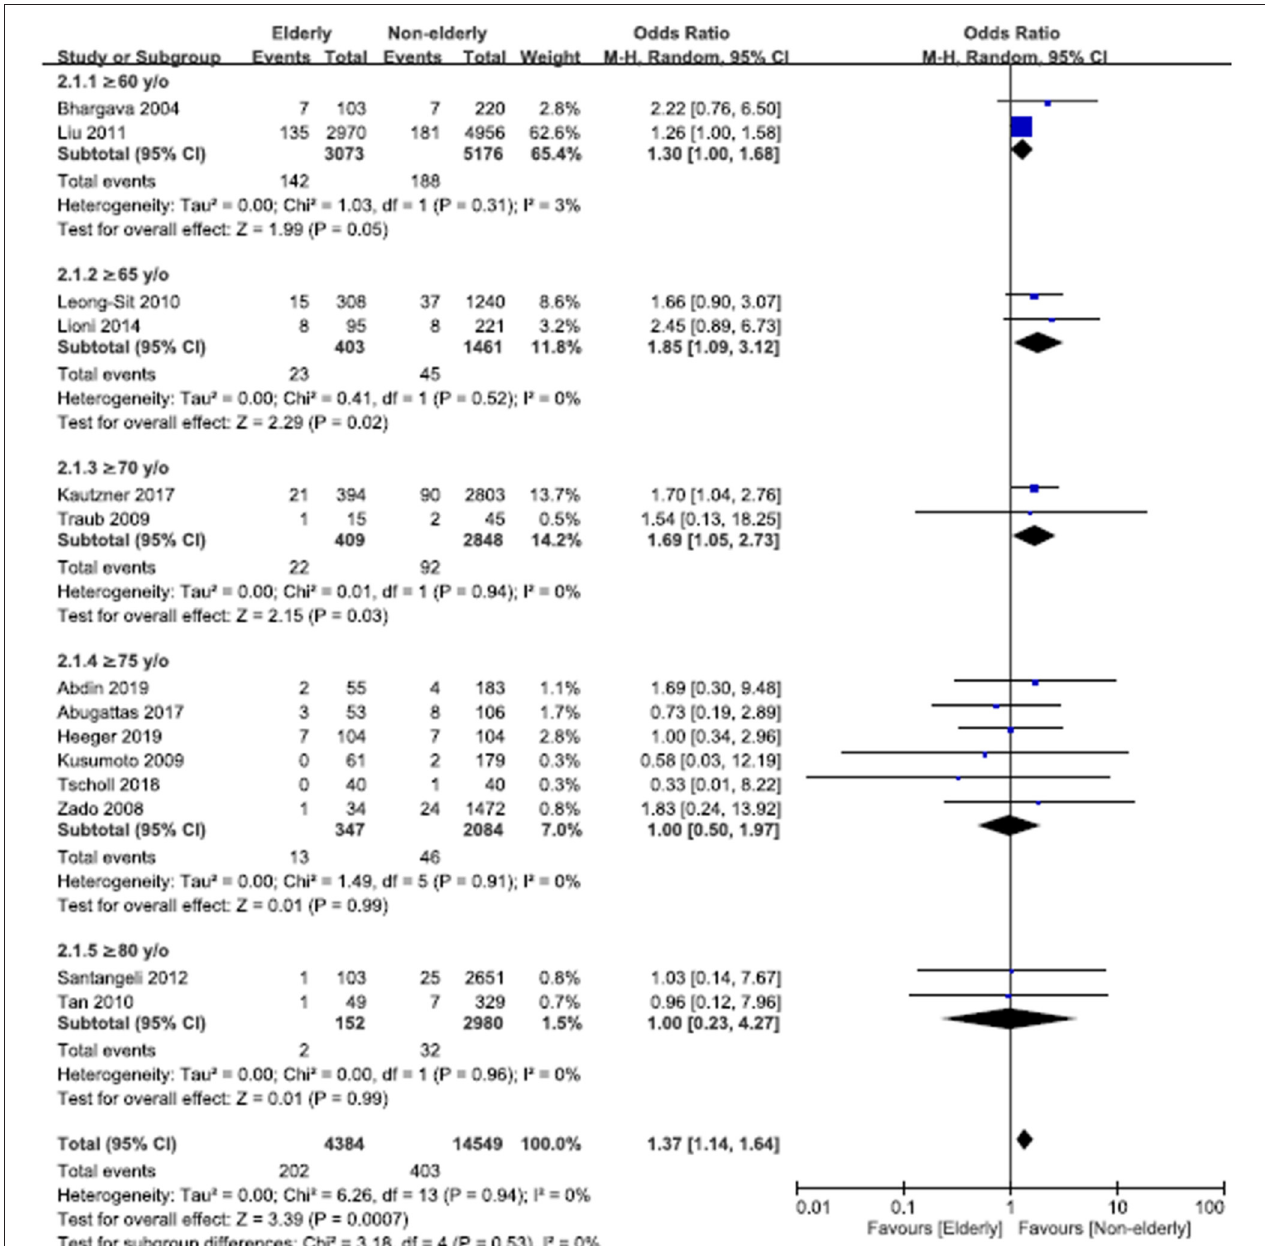
FIGURE 5 | Forest plots of the overall OR of complications of AF ablation between the elderly and non-elderly groups in the entire population with different age distributions from 14